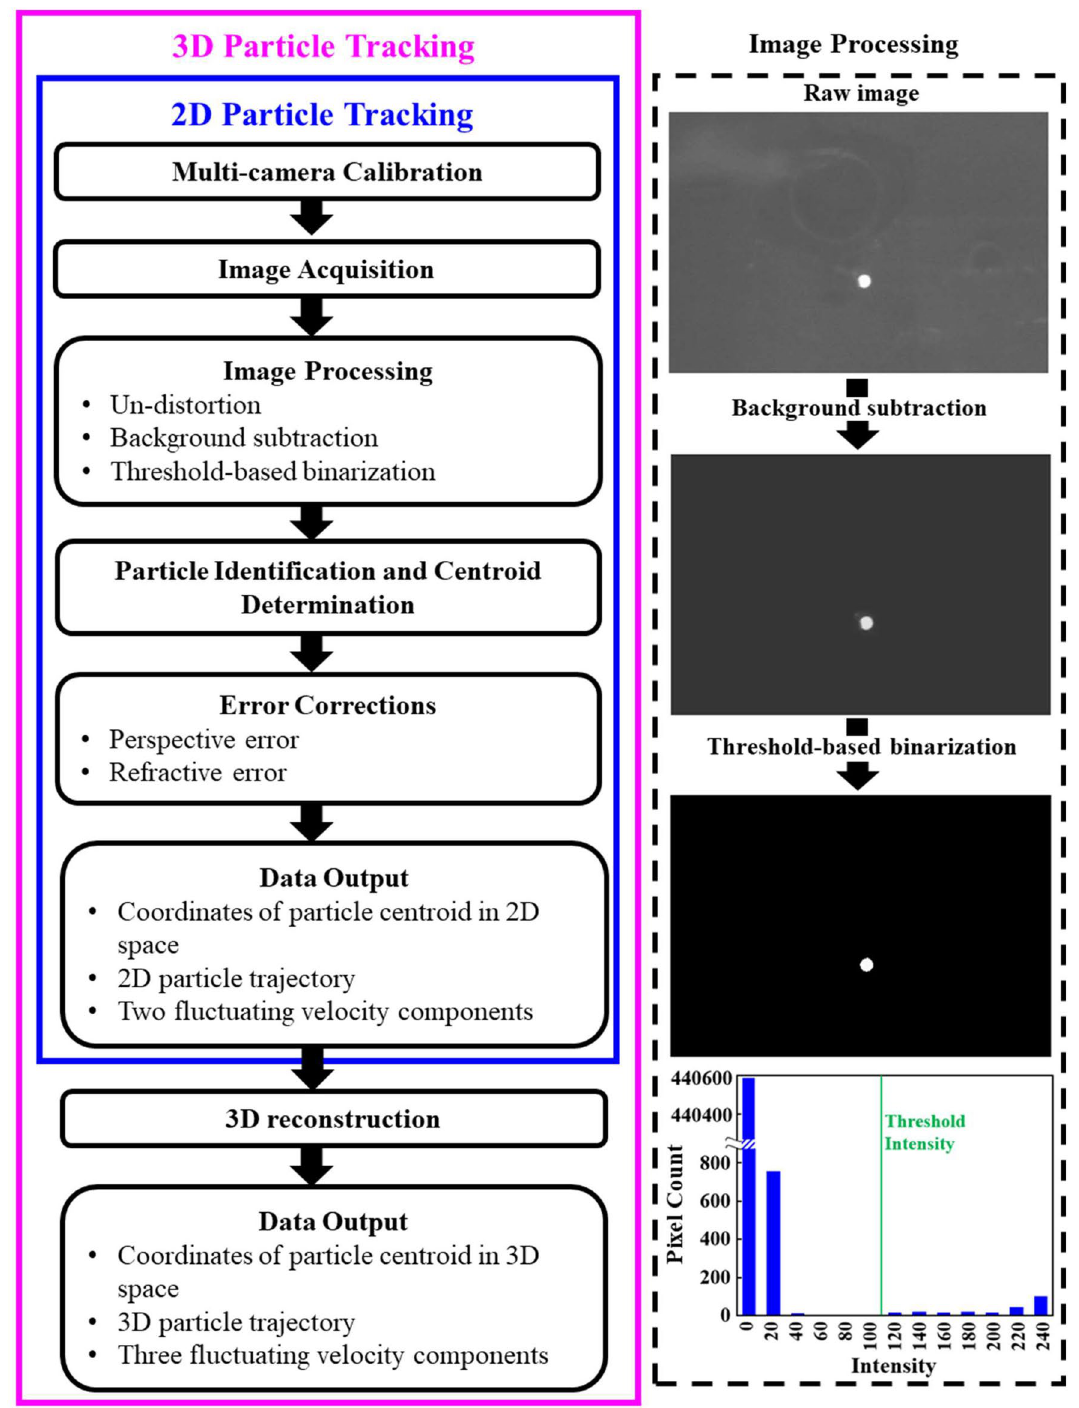
Figure 2. Left: Flow chart of SPTV velocimetry. Right: Demonstration of image processing method and determination of threshold intensity for threshold-based